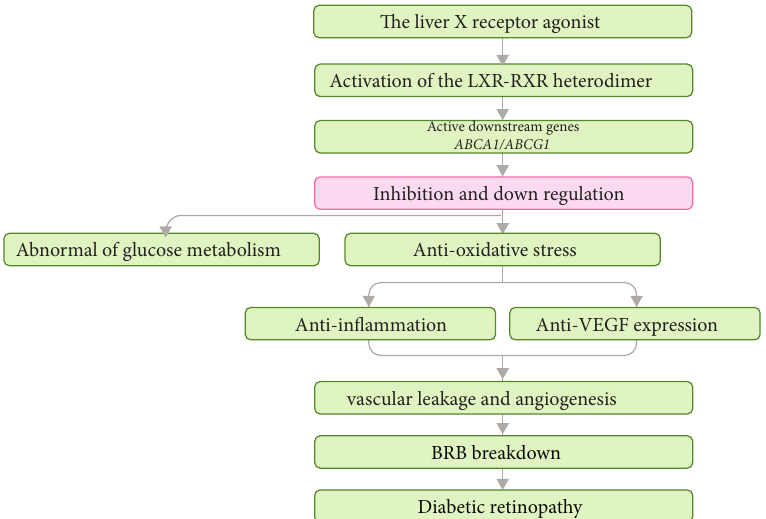
Figure 2: The liver X receptor agonist and diabetic retinopathy. This fl ow diagram illustrates the regulatory mechanism of activation of LXR signaling by the LXR agonist in DR. LXR: liver X receptor; BRB: blood-retinal breakdown; RXR: retinoid X receptor; DR: diabetic